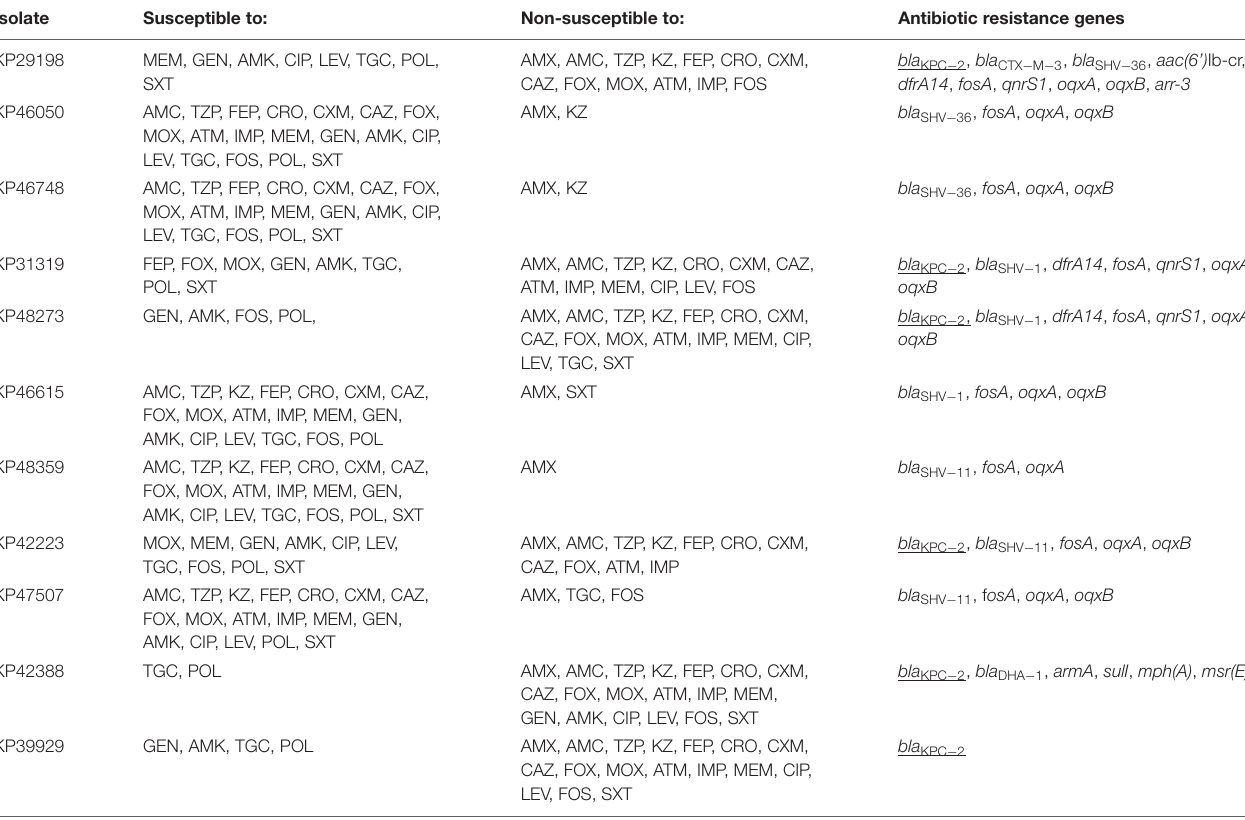
TABLE 2 | Antimicrobial susceptibility and antibiotic resistance genes of 11 isolates of K. pneumoniae isolated from blood cultures from patients with bloodstream infections at a Chinese hospital. Carbapenem resistance genes are underlined. Isolate Susceptible